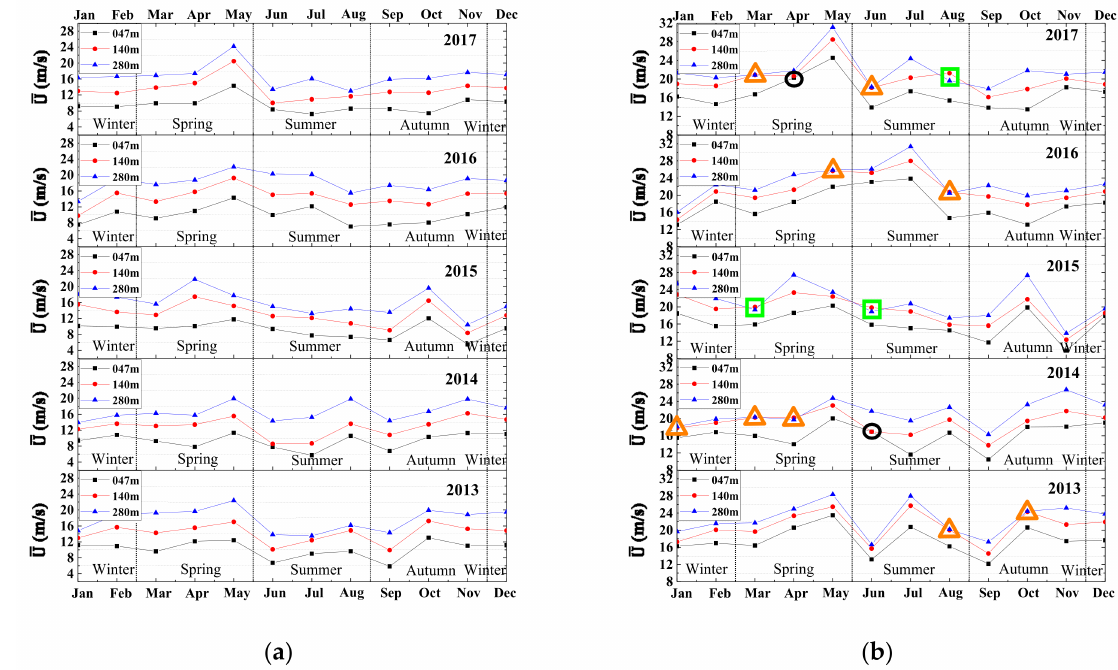
Figure 6. Distribution of the monthly maximum wind speed with time intervals of 10 min ( a ) and 3 s ( b ) from 2013–2017. Orange triangles: the trend lines related to 140 m and 280 m are very close; green squares: the gust wind speed at the height of 140 m even exceeds the wind speed at the height of 280 m. Black circles: the maximum gust wind speeds at the height of 47 m and 140 m are very close.